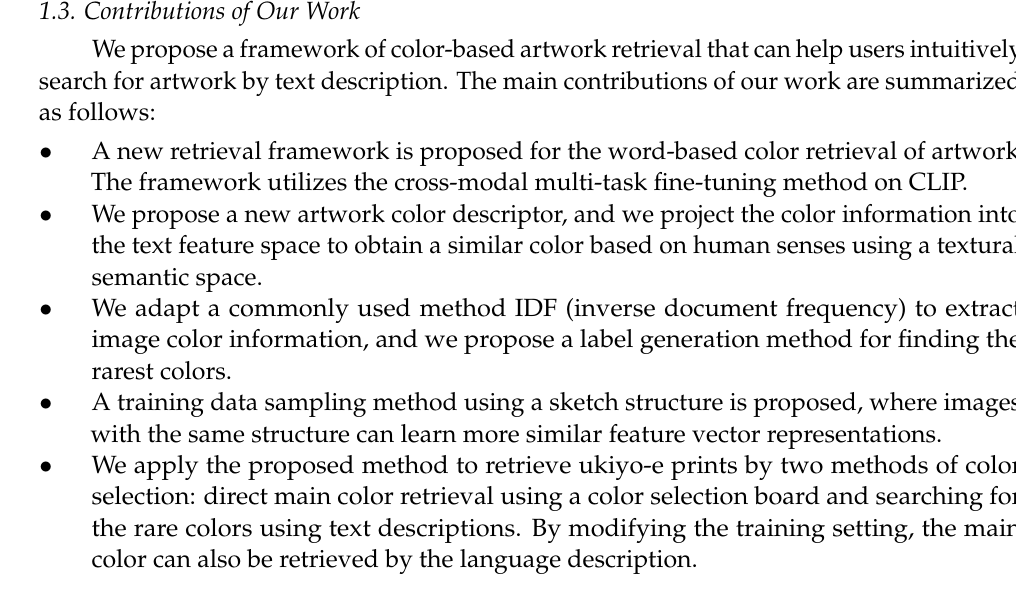
Figure 4. Results for ‘yellowish blue’ using text-image search and image-image search.